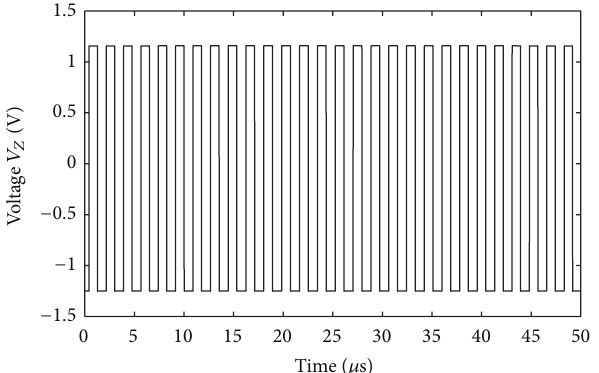
Figure 11: Voltage 𝑉 𝑍 of pulse generator.